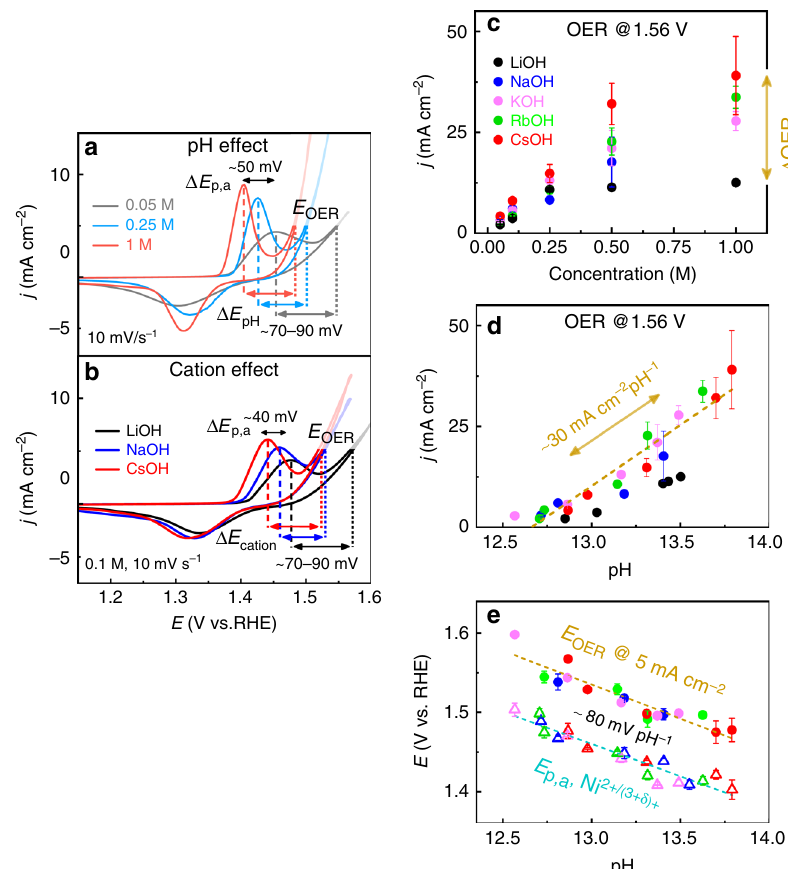
Fig. 4 The electrolyte pH as OER activity descriptor. a CVs at 10 mV s − 1 of Ni 65 Fe 35 (OOH) in 0.05 M, 0.25 M, and 1 M CsOH, to demonstrate the effect on the OER activity of increasing pH from low to high concentrations. b CVs at 10 mV s − 1 in 0.1 M LiOH, 0.1 M NaOH, and 0.1 M CsOH, to demonstrate the typical peak shift induced from small to large cations. c Current density ( j ) at 1.56 V vs. RHE plotted against the electrolyte concentration. d Current density at 1.56 V vs. RHE plotted against the electrolyte pH. e The OER potential ( E OER ) at 5 mA cm − 2 ( fi lled circles) and the anodic peak potential ( E p,a ) of the Ni 2 + ↔ Ni (3 + δ ) + redox peak from CVs at 10 mV s − 1 (hollow up-pointing triangles). The color code for the alkali metal hydroxides shown in the legend in c also applies to d , e . The pH in LiOH was determined with an alternative method (Supplementary Note 3), and is therefore excluded from the fi t line in d and not shown in e for clarity. Error bars show the standard error from the overall number of